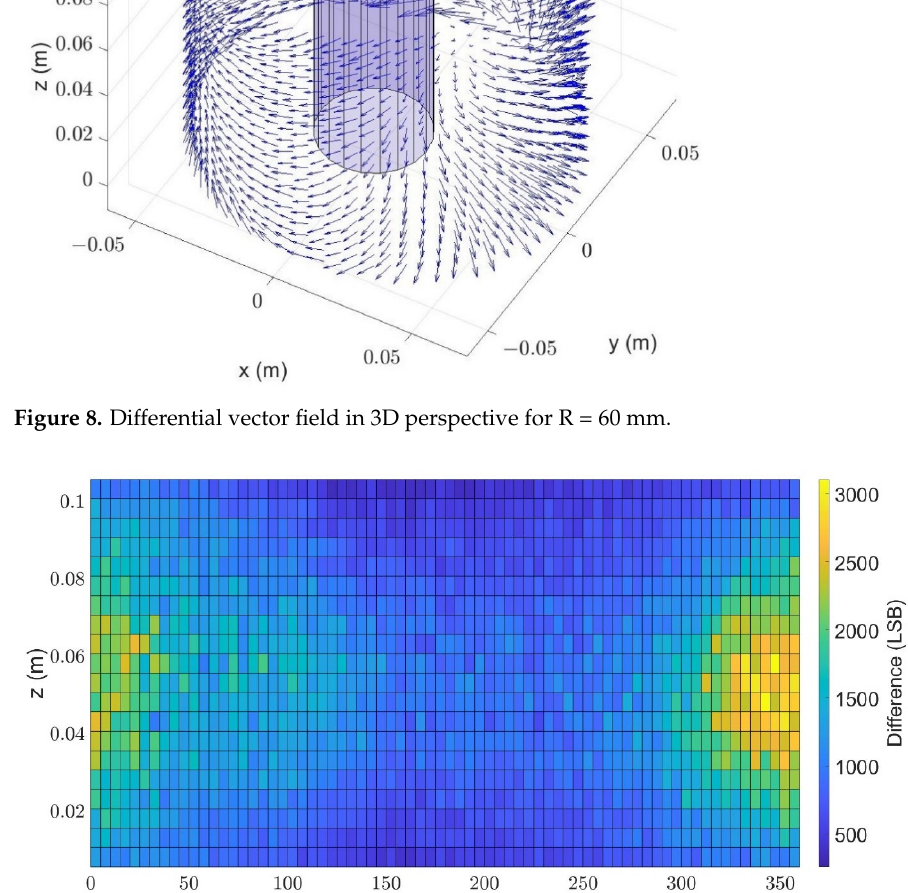
Figure 8. Differential vector field in 3D perspective for R = 60 mm.